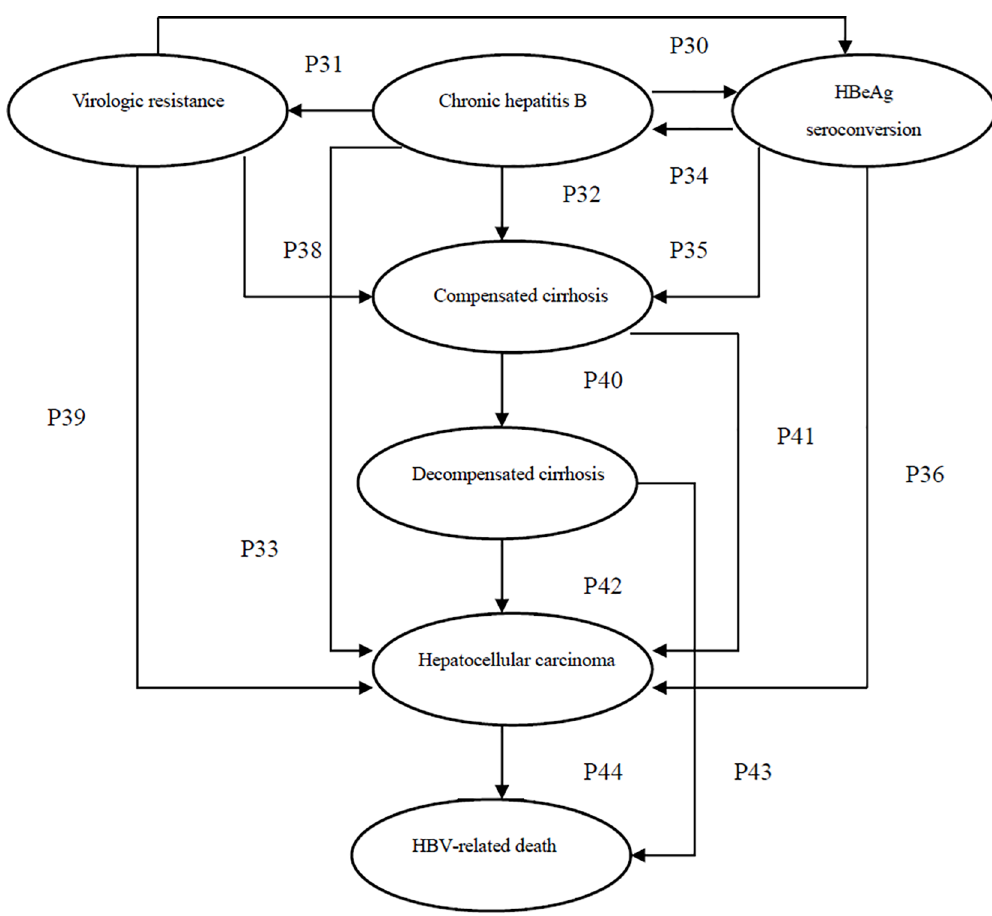
Fig 1. Markov diagram of health states and possible transitions between